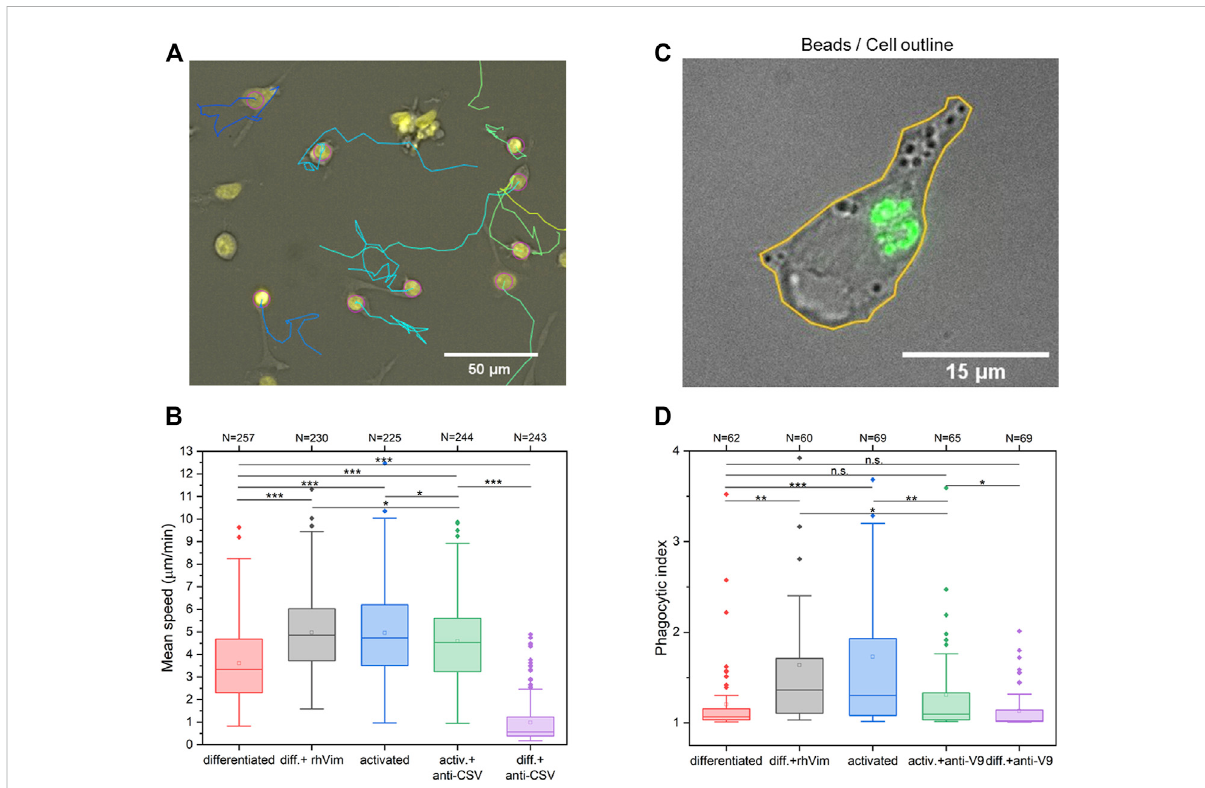
FIGURE 6 Stimulation of migration and phagocytosis of macrophages by addition of recombinant (rh)Vimentin. (A) Migration tracks of TNF- α – activated macrophages visualised using TrackMate ImageJ plugin. (B) Quanti fi cation of migration speeds of differentiated macrophages without and with addition to the medium of 100 ng/ml rhVimentin and anti-cell-surface vimentin antibody, and of TNF- α – activated macrophages without and with addition of the anti-cell-surface vimentin antibody (CSV). (C) Visualisation of fl uorescent beads (green) phagocytosed by a TNF- α – activated macrophage using fl uorescence microscopy. Cell outline (yellow) de fi ned from phase contrast image. (D) Phagocytic index determined by the fl uorescence intensity within the differentiated macrophages without and with addition of 100 ng/ml rhVimentin and anti-vimentin antibody (V9), and of TNF- α – activated macrophages without and with addition of the anti-vimentin antibody (V9). *, p < 0.05; **, p < 0.01; ***, p < 0.001. n.s. not signi fi cant (Student ’ s t-tests). All experiments were repeated three times. The data is presented as box plots with whiskers drawn within the 1.5 IQR value. N indicates the total number of cells analyzed.All experiments were done three